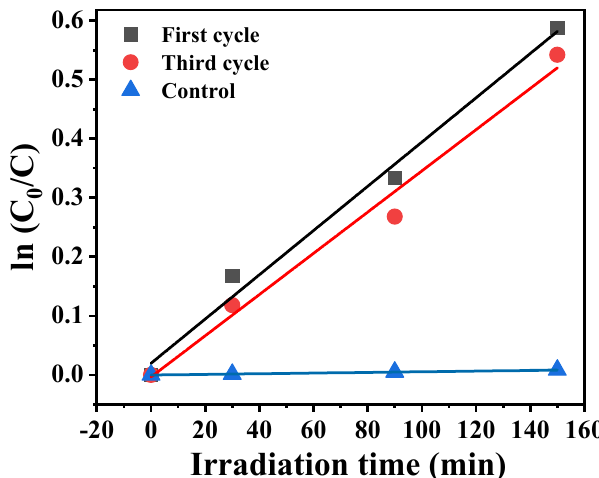
Fig. 9. Re-usability of Mg (OH)